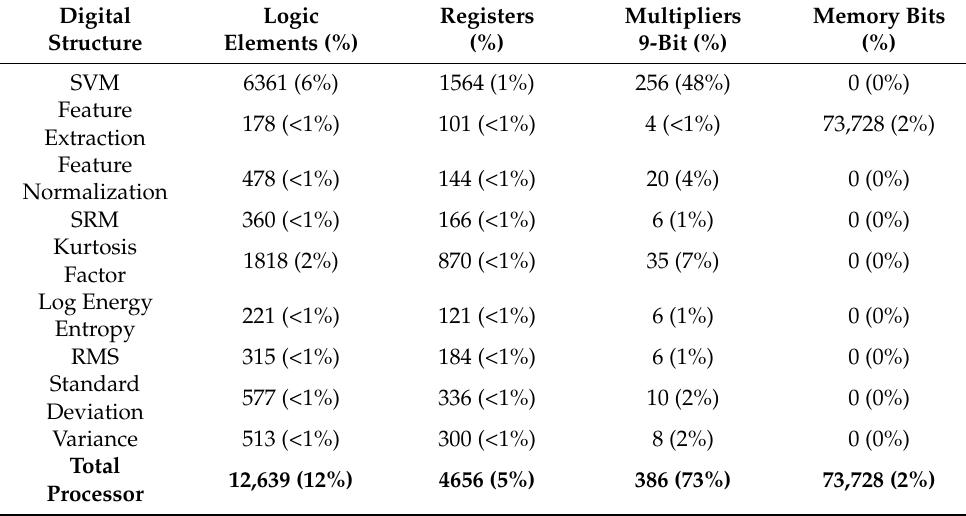
Table 5. FPGA resources